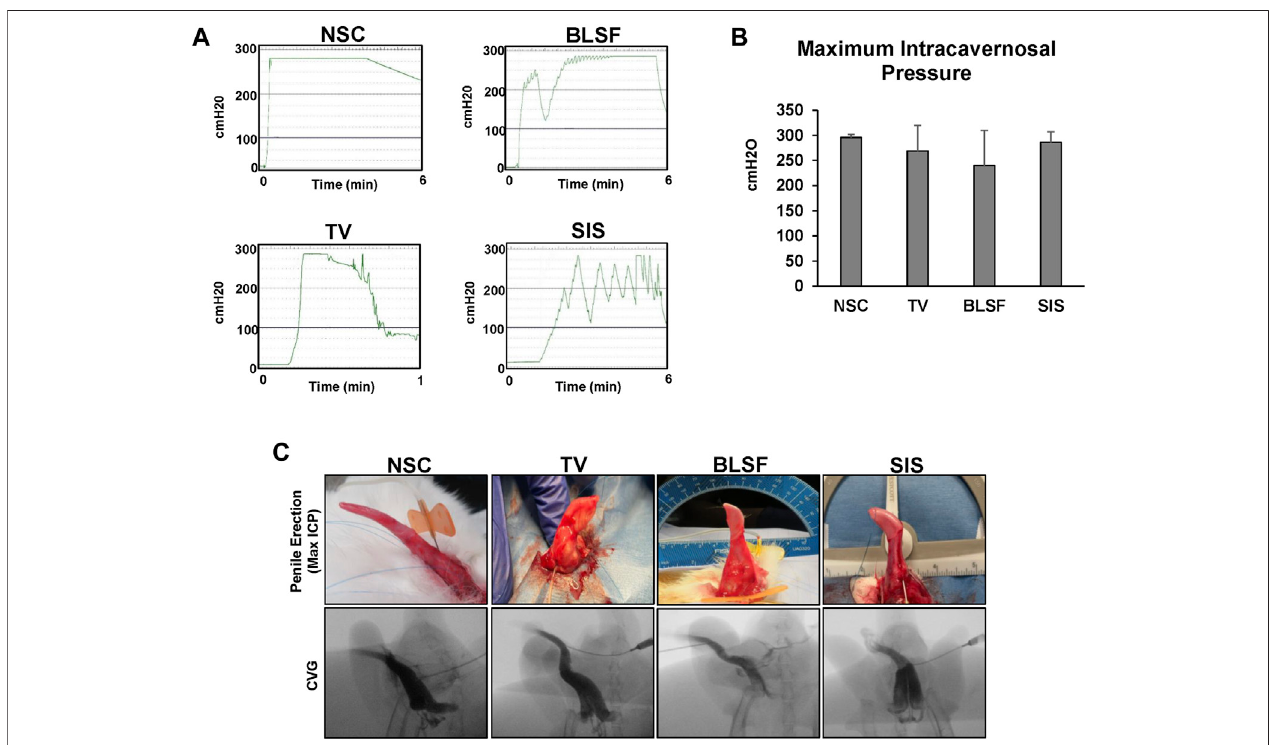
FIGURE 2 | Cavernosometric and cavernosographic evaluations of control and reconstructed penile tissues. (A) Representative intracorporal pressure (ICP) tracings from NSC and animals repaired with BLSF, TV, or SIS implants and assessed at 3 months post-op. (B) Maximum ICP levels achieved in experimental groups describedin (A) .Valuesarepresentedasmeans ± SD. N (cid:1) 3 – 5replicatesperdatapoint.ResultsfromallgroupswereanalyzedwithKruskal – Wallistestyielding p > 0.05. (C) Representativephotomicrographs ofpenile erections and cavernosographic fi ndingsat maximum ICP levels following contrast instillation forgroups described in (A) . NSC, nonsurgical controls; BLSF, bi-layer silk fi broin scaffold; TV, tunica vaginalis; SIS, small intestinal